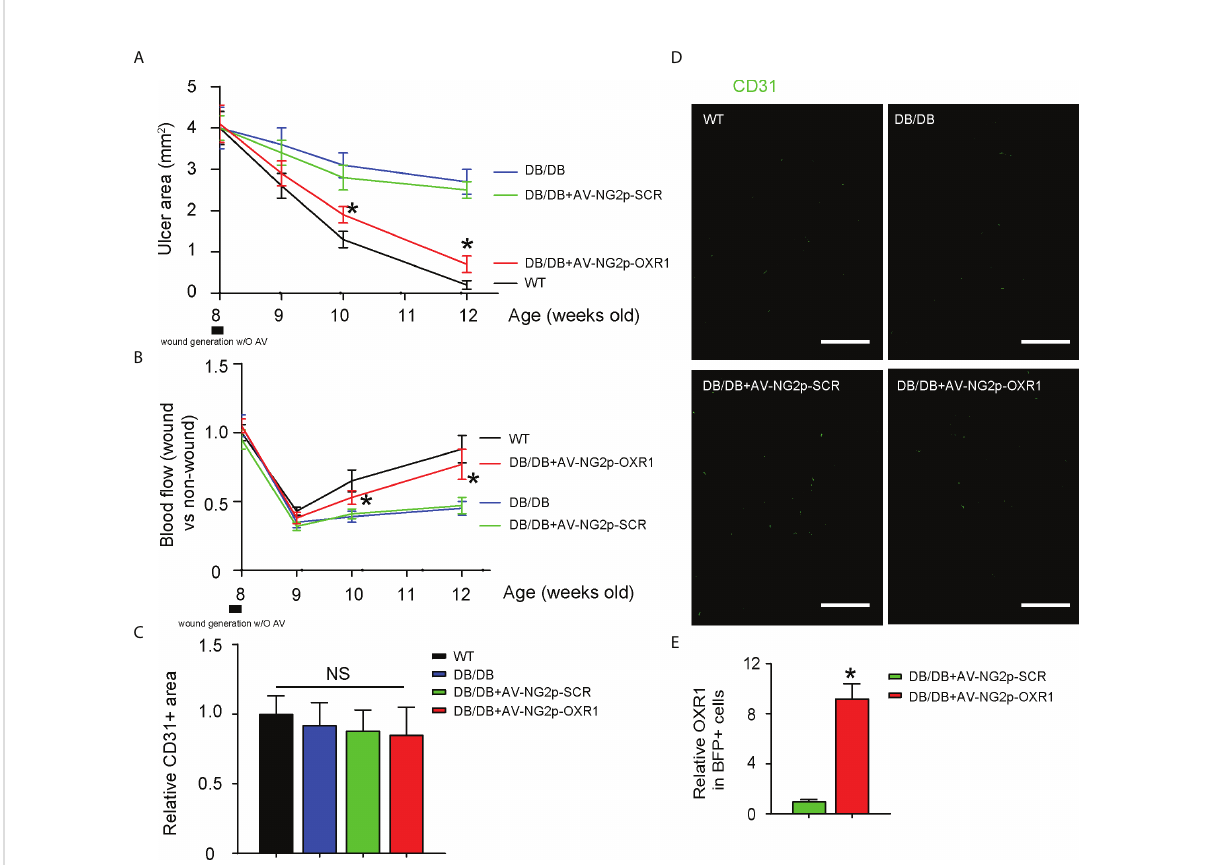
FIGURE 6 Gene therapy with AV-NG2p-OXR1 improves diabetic wound healing, likely through enhancing blood fl ow at the wound rather than increasing vessel density. (A) Changes in ulcer area with time. (B) changes in blood fl ow with time. (C, D) Vessel density at analysis (12 weeks old, or 4 weeks after wound generation with/without saline/virus injections), shown by quanti fi cation (C) and by representative fl uorescent images (D) . (E) RT-qPCR for OXR1 in BFP+ cells isolated from the wound. * p < 0.05. NS, non-signi fi cant. N = 5. Scale bars are 100